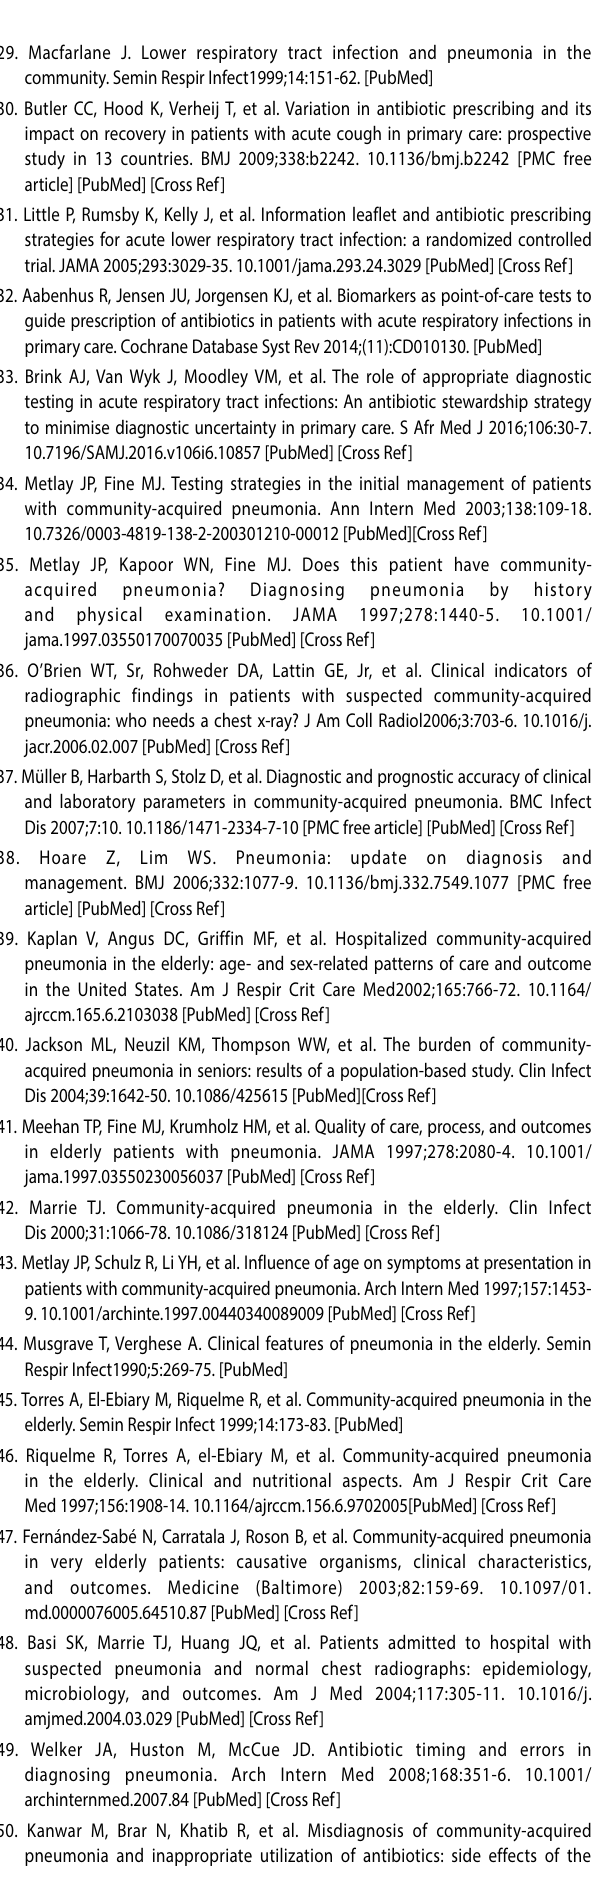
The page number in the footer is not for bibliographic